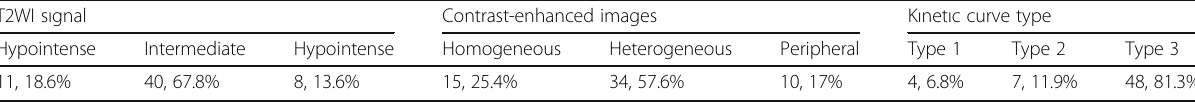
Table 3 Signal characteristics and kinetic curve types of the lesions T2WI s ı gnal Contrast-enhanced images